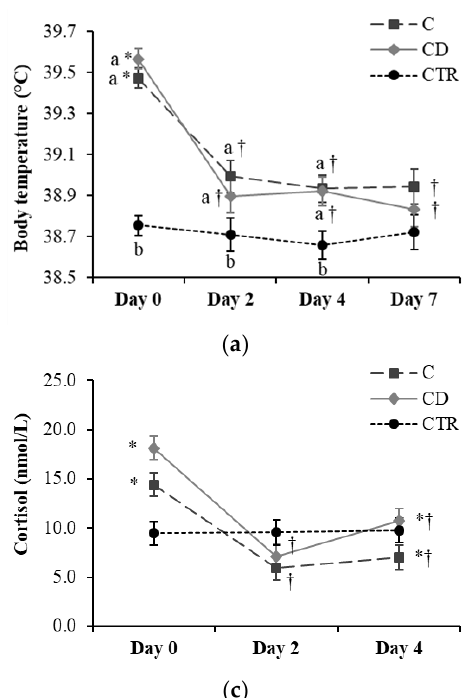
Figure 2. Evolution over time of ( a ) body temperature, ( b ) haptoglobin, and ( c ) cortisol serum concentration in the three treatment groups of 20 cows each (C = ceftiofur; CD = ceftiofur + ketoprofen; CTR = control). Least square means and standard errors as resulted from the general linear model are reported. a,b Different letters indicate differences between the three groups (C, CD, and CTR) over time ( p < 0.05). *,† Different symbols indicate differences within the groups C and CD over time ( p < 0.05).